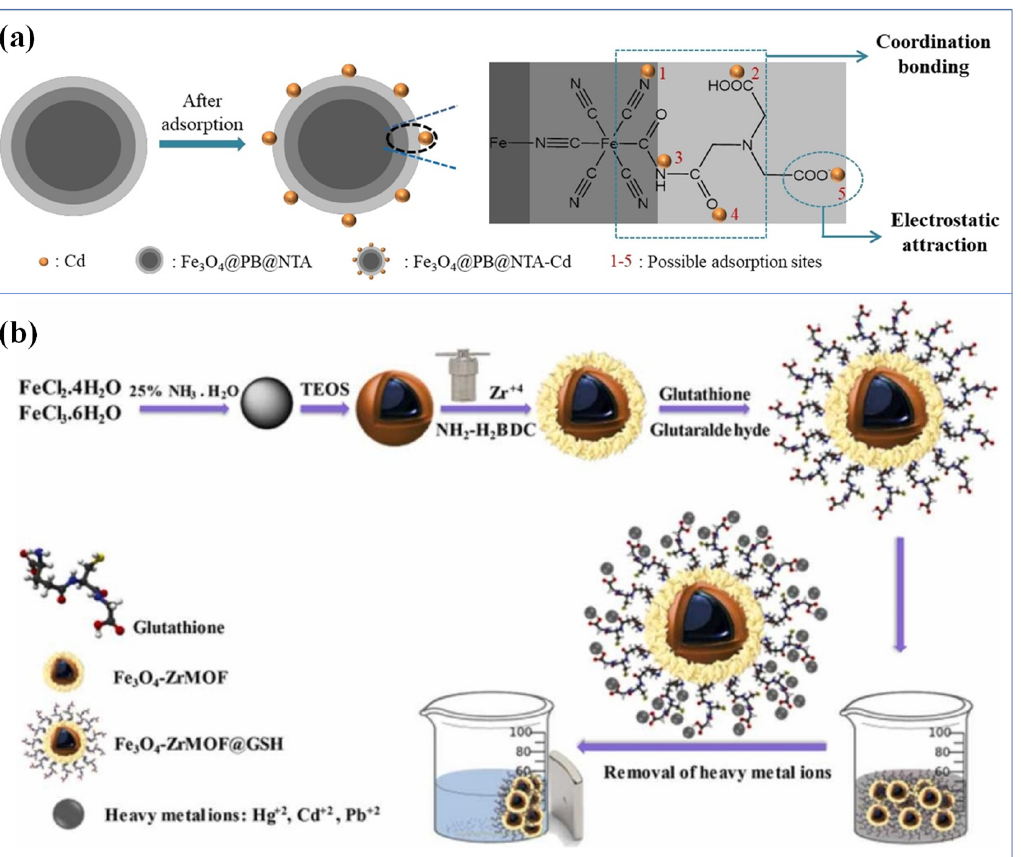
Figure 12. ( a ) The adsorption mechanism of Fe 3 O 4 @PB@NTA [115], with permission from Elsevier, 2022; ( b ) The preparation procedure of Fe 3 O 4 -ZrMOF@GSH and removal of selected heavy metals from aqueous solution reproduced from [117], with permission from Elsevier, 2022.